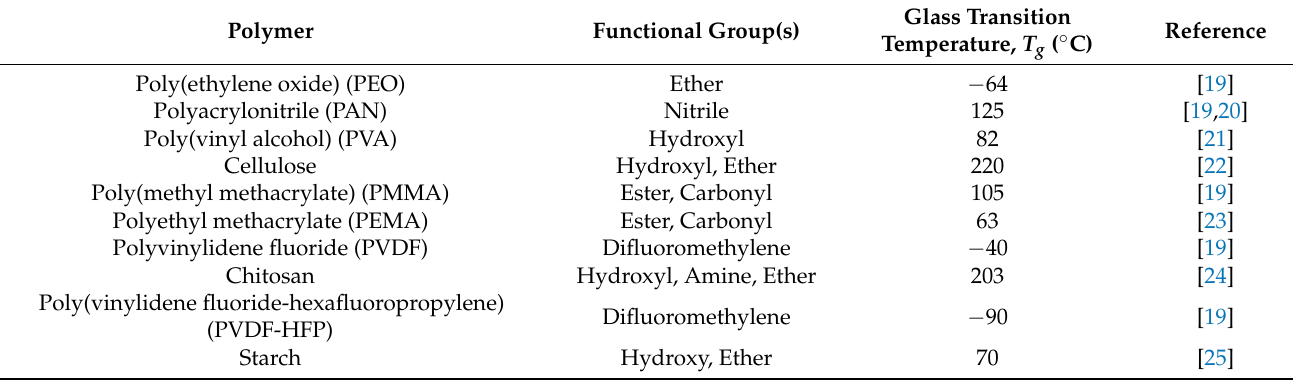
Table 1. Typical polymers used in polymer electrolytes, along with their characteristics. Polymer